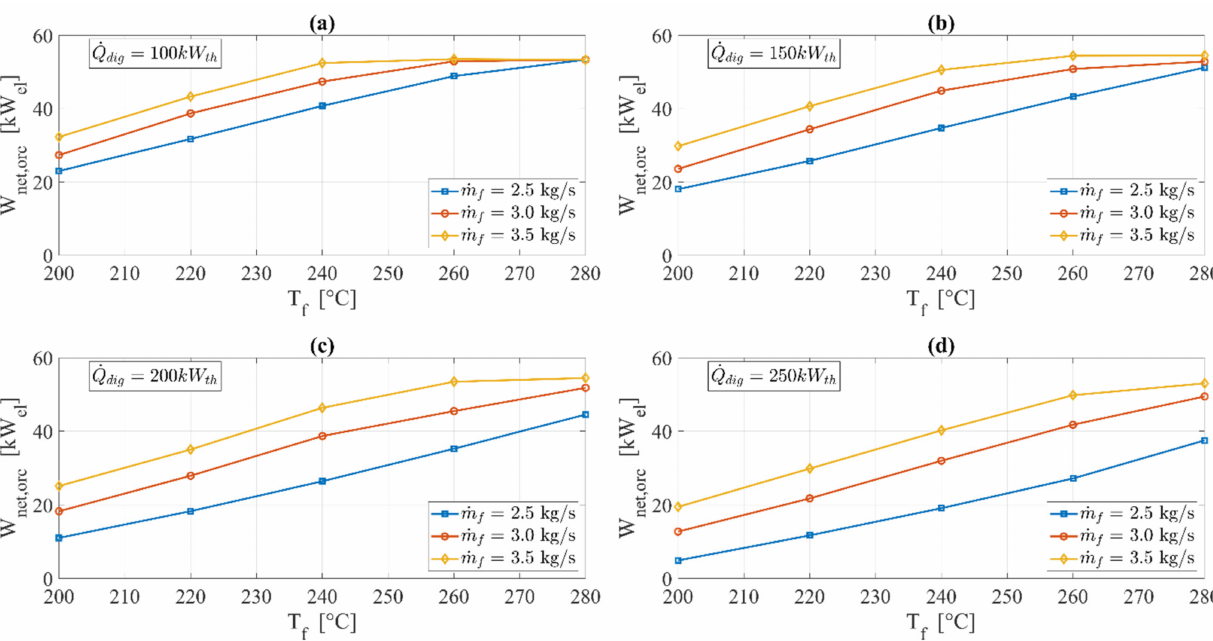
Figure 7. Off-design ORC maps. ORC power output W net,orc was mapped for several representative values of the heat flow rate required by the digester the mGT exhaust mass flow rate